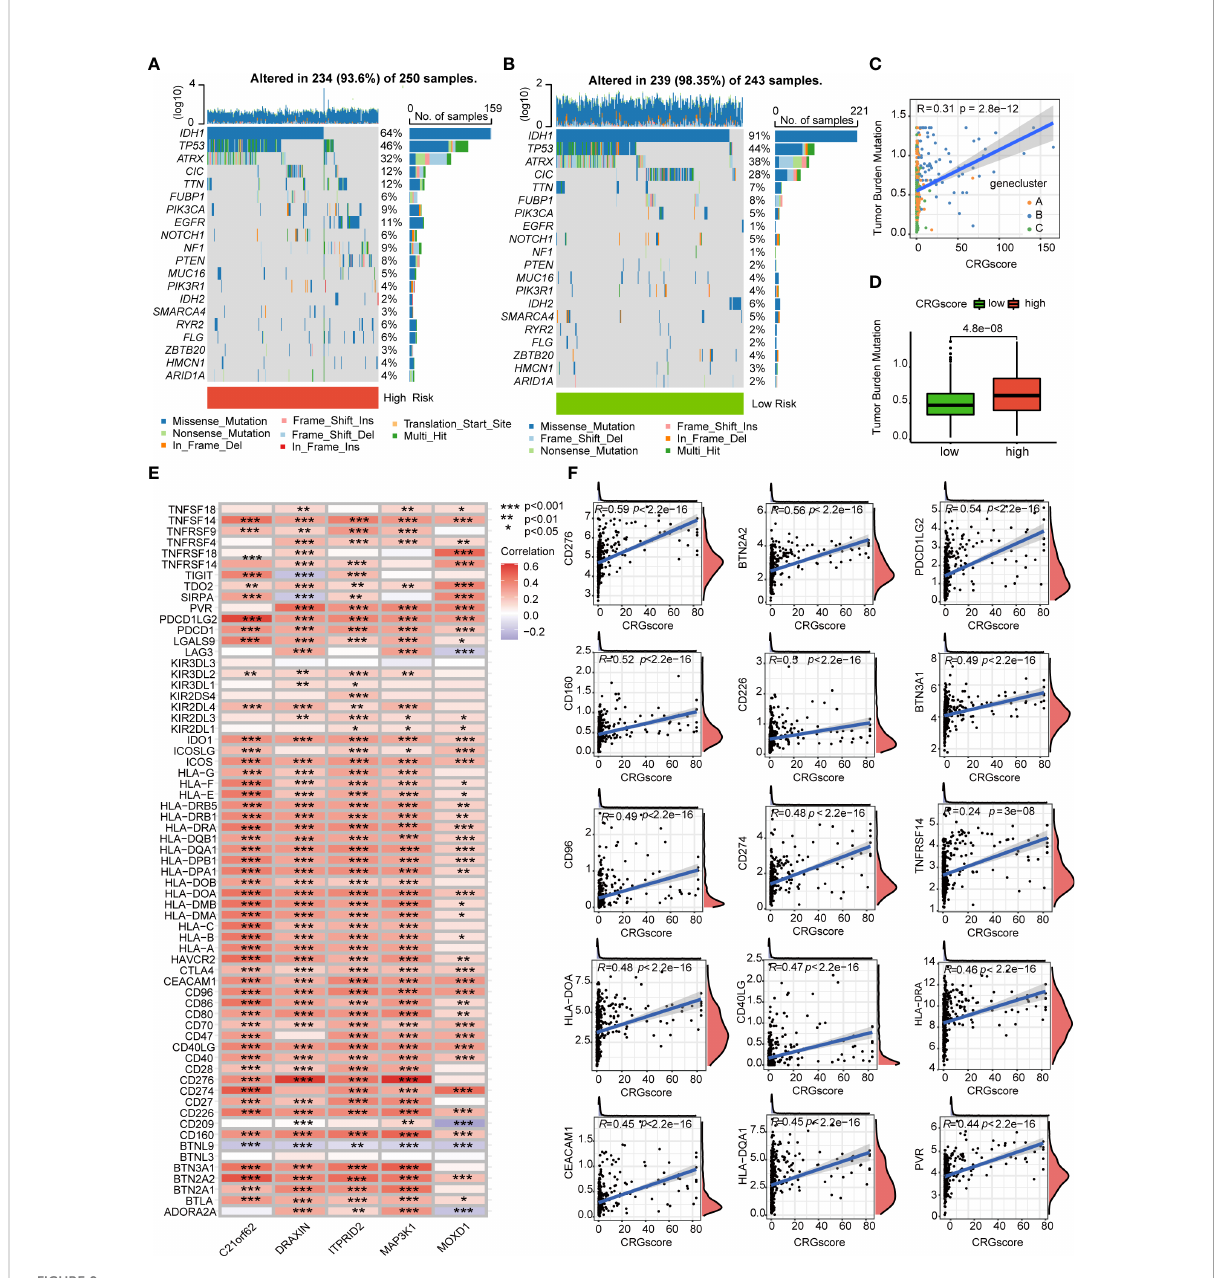
FIGURE 9 Correlations of the CRG score with TMB and ICGs in LGG. (A, B) The mutational landscape of LGG patients in high- and low-risk groups. (C) Correlations between the TMB and the CRG score in different gene clusters. (D) Difference in the TMB scores between high- and low-risk groups. (E) Correlations between the expression of ICGs and fi ve genes in the cuproptosis-related prognostic model. (F) Correlations between the expression of ICGs and the CRG score. P -values were shown as: * P <0.05; ** P <0.01; *** P <0.001. CRGs, cuproptosis-related genes; TMB, tumor mutation burden; ICGs, immune checkpoint genes; LGG, lower-grade glioma (WHO II and